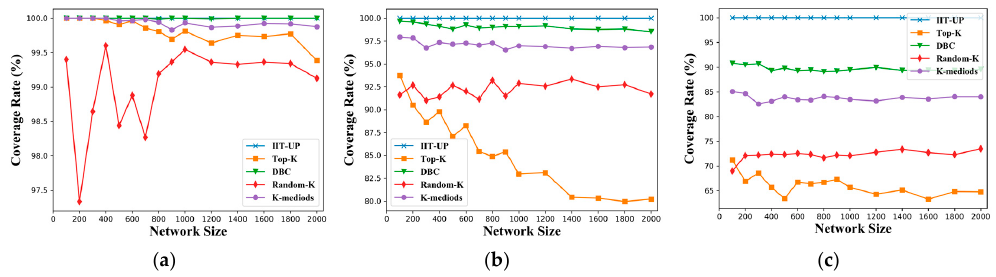
Figure 10. The coverage rate of K placement algorithms. ( a ) The layer with the latency upper bound at 50 ms. ( b ) The layer with the latency upper bound at 25 ms. ( c ) The layer with the latency upper bound at 10 ms.